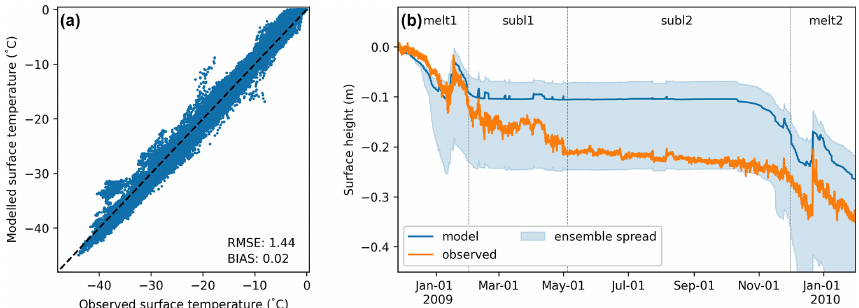
Figure 4. (a) Observed versus modelled surface temperature and (b) surface height change, where model represents the optimal ensemble simulation. In (b) , blue shading indicates the ensemble spread represented by the standard deviation with respect to the ensemble